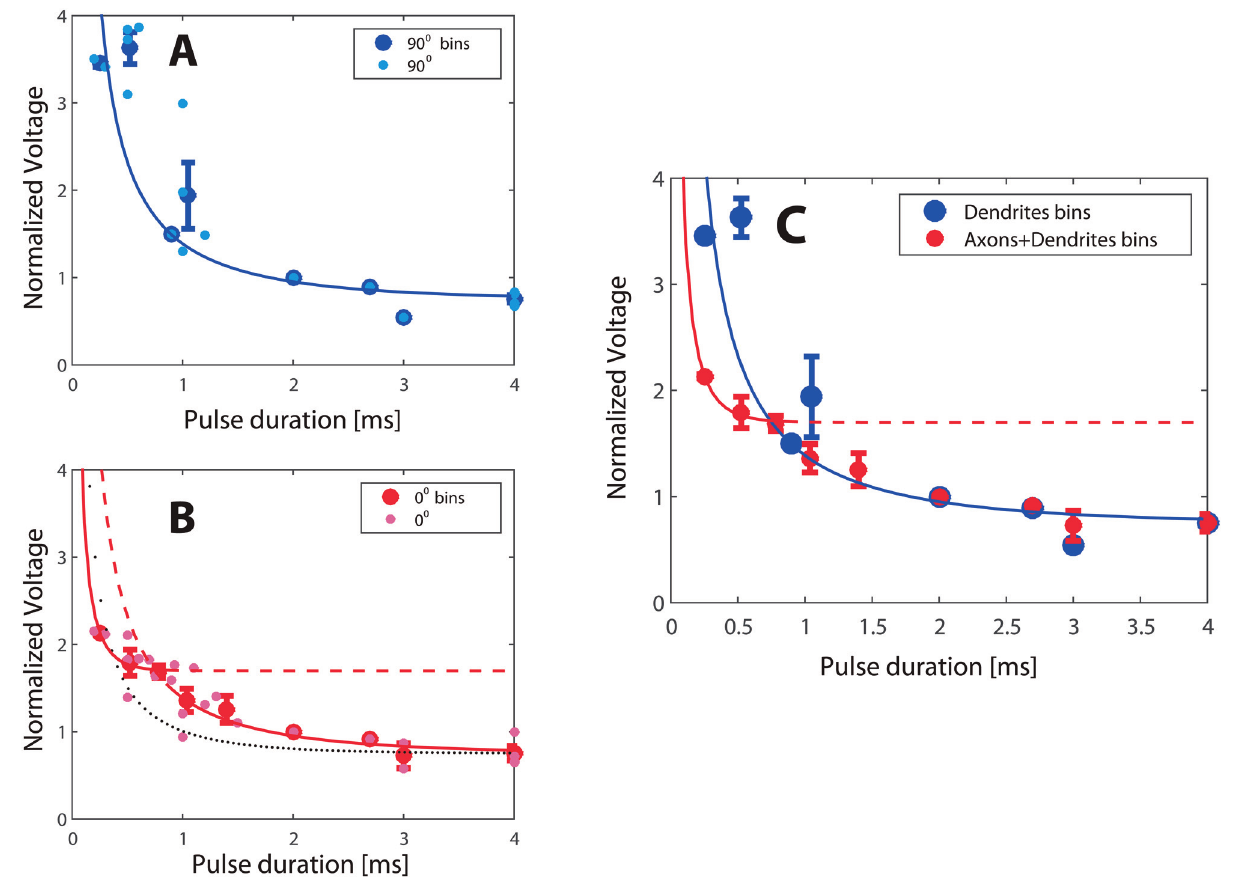
Fig 3. Measured Strength-Duration (SD) curves. Strength was measured as a population response (see Methods). A total of n = 33 experiments are presented. The linear cultures were grown on 9 different dishes, each dish contained 5 lines and each line was typically stimulated for 3 or 4 different pulse durations. 1D cultures were stimulated first at 0° for different durations and of these n = 25 were also stimulated at 90°. All dishes were stimulated at 2ms to allow normalization (see Methods). (A) Voltage needed to excite the culture ( ‘ Strength ’ ) is plotted as a function of the pulse duration, with the field at 90° to the line. Small light blue filled circles denote measured data; large blue circles denote binned data. The blue line is the best fit with τ = (1.3 ± 0.4) ms, as described in the text. (B) Strength-Duration with the field parallel (0°) to the line of the culture. Small pink squares denote individual measured data points; red large squares denote binned data. Black dotted line is a fit with a single time constant. The two red lines are obtained using a fit with two time constants; For durations shorter than 1 ms: τ = (160 ± 20) μ s, and above 1 ms: τ = (1.4 ± 0.2) ms. The curve for the long durations almost completely merges with the 90° curve, indicating that indeed the same mechanisms are active as in the dendrites stimulation. (C) Data from electric field orientation with respect to the linear culture at 0° and 90° together. From the 90° curve we derive the time constant of the dendrites. The 0° curve diverges from the 90° curve at short pulses. From the data in short pulses we derive the time constant of the axons. Dendrites can be seen to be more sensitive to excitation at pulses longer than 1 ms, with a Rheobase of 0.75 Vnorm compared to 1.7 Vnorm of the axons, while axons are more sensitive to excitation at pulses shorter than 1